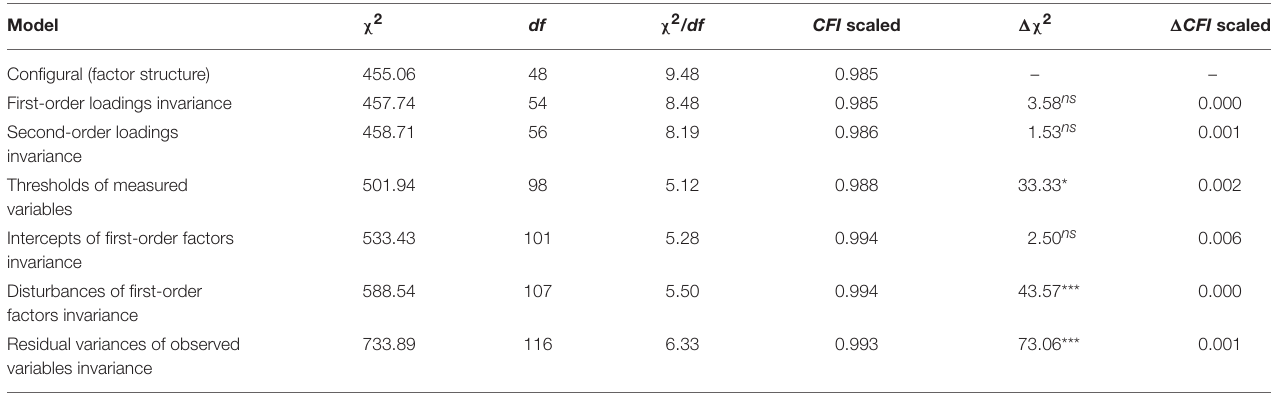
TABLE 7 | UWES-9 second-order three-factor latent model comparison between countries. Model χ 2 df χ 2 / df